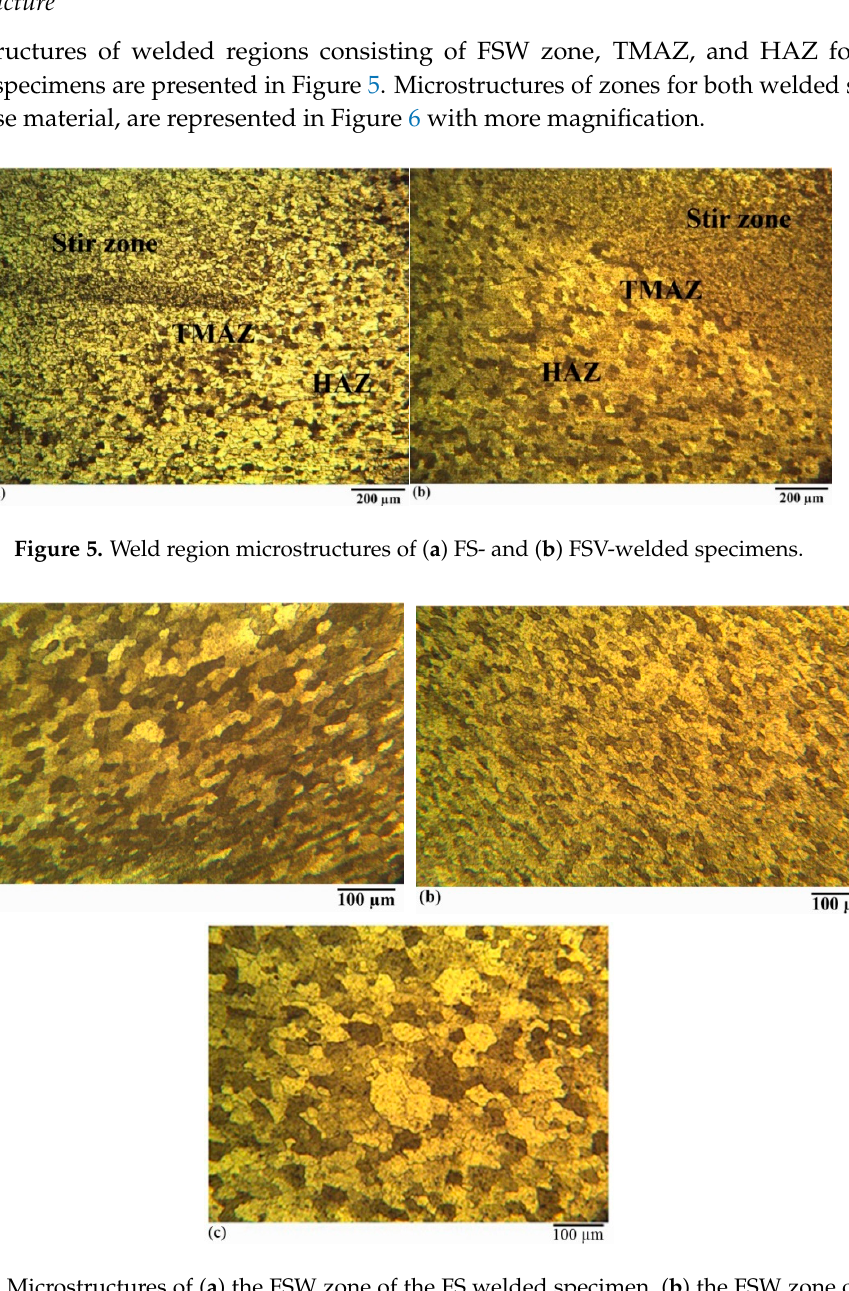
Figure 6. Microstructures of ( a ) the FSW zone of the FS welded specimen, ( b ) the FSW zone of thre FSV-welded specimen, and ( c ) the base material.